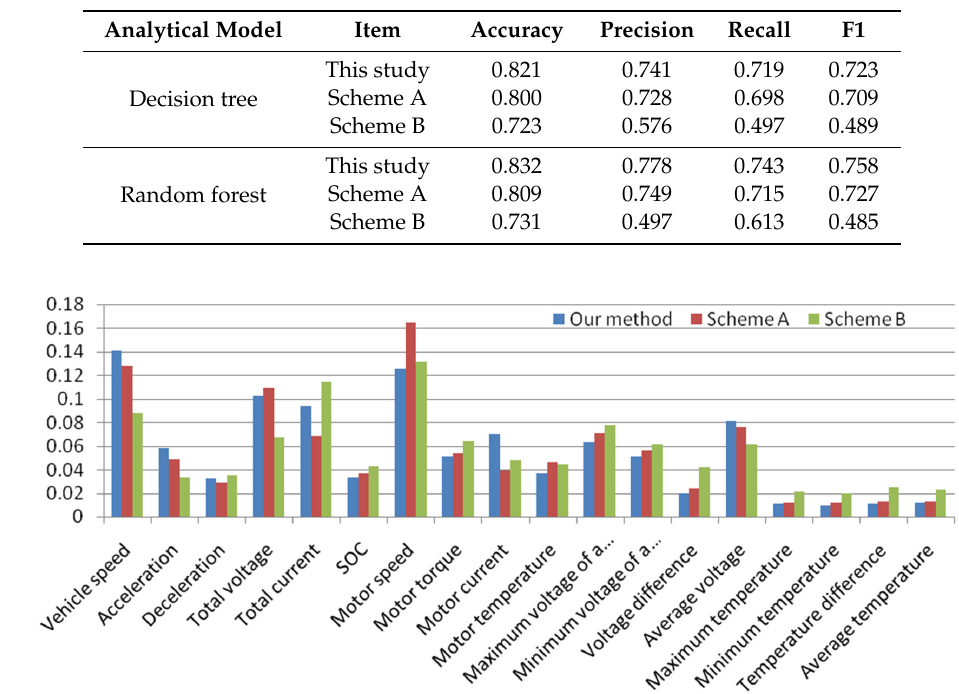
Table 9. Statistics of classification indicators of various schemes in the case study.